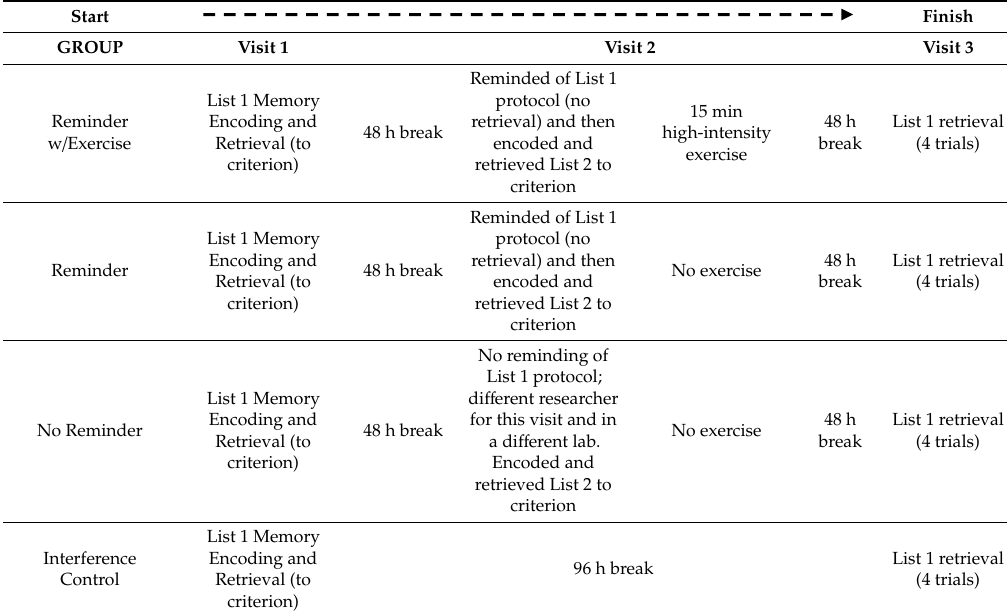
Table 2. Study protocol overview.